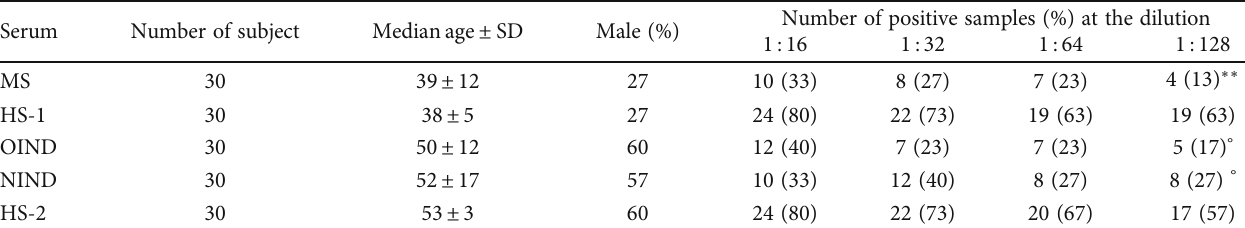
Table 3: Prevalence of serum IgG antibodies against BKPyV analyzed by hemagglutination inhibition (HAI)